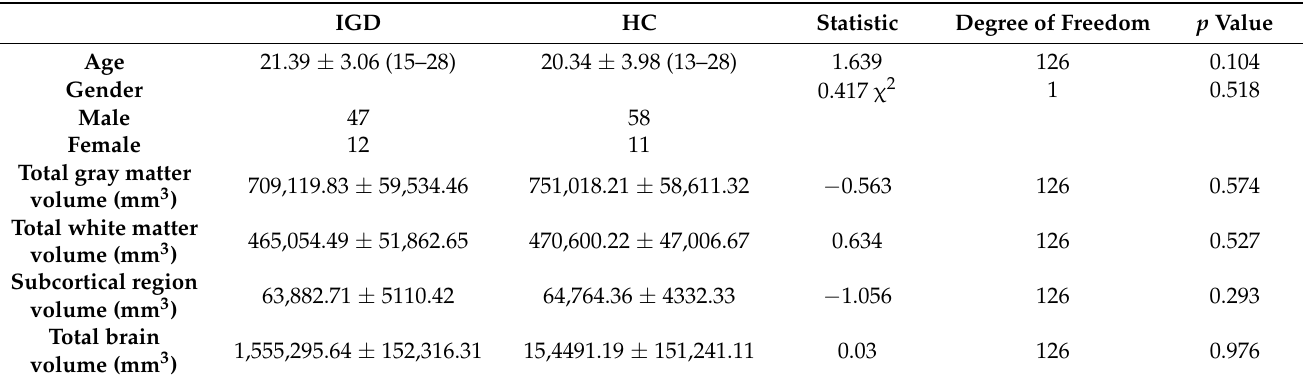
Table 1. Demographic statistics.